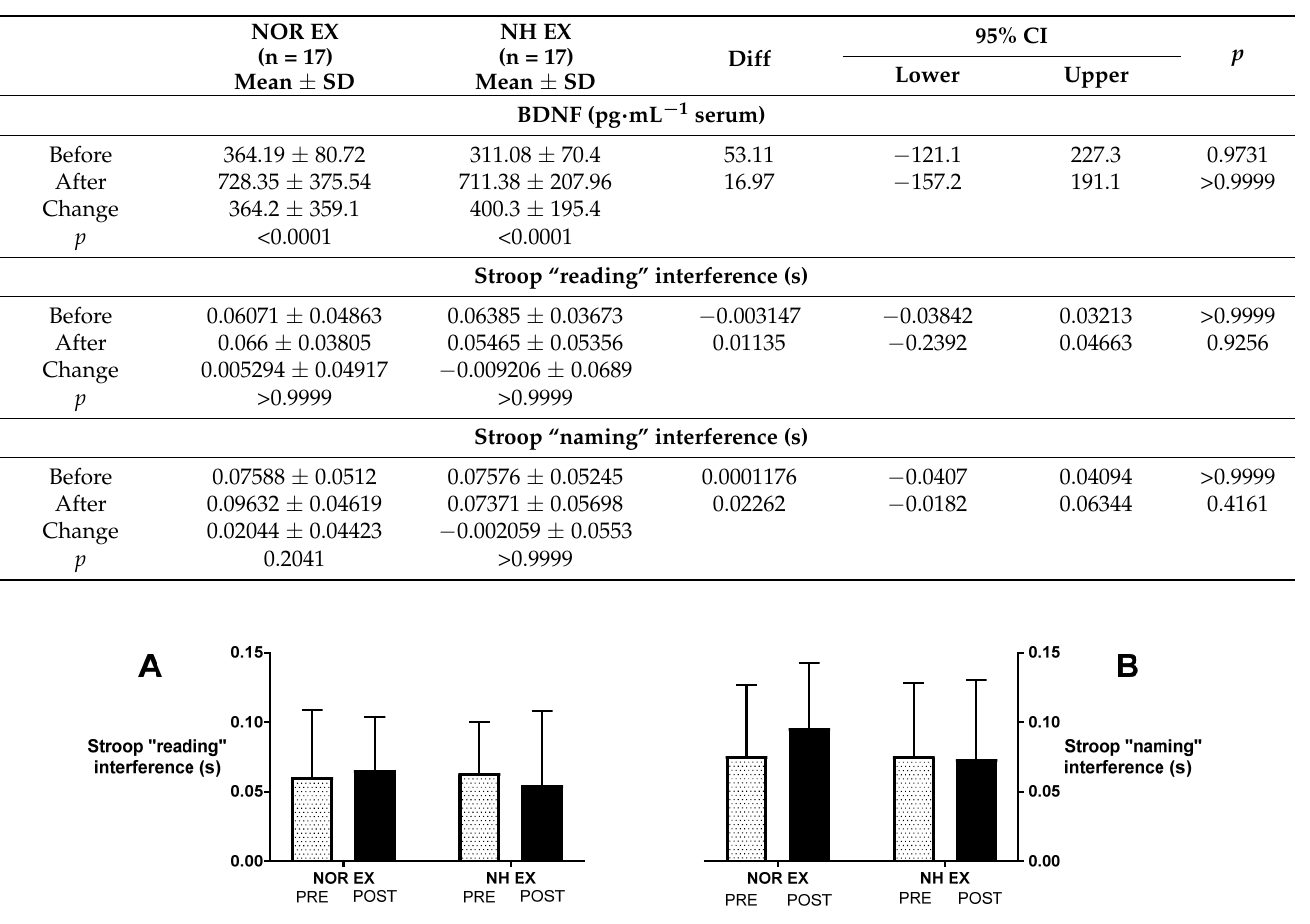
Table 2. Effect of intervention on BDNF concentration and Stroop interference results.